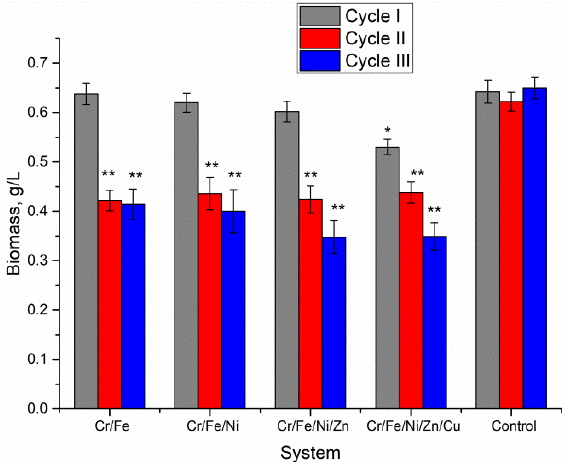
Figure 1. Biomass of Nostoc linckia obtained during three cycles of cultivation on media containing metal ions (* p < 0.005; ** p < metal ions (* p < 0.005; ** p < 0.001) .